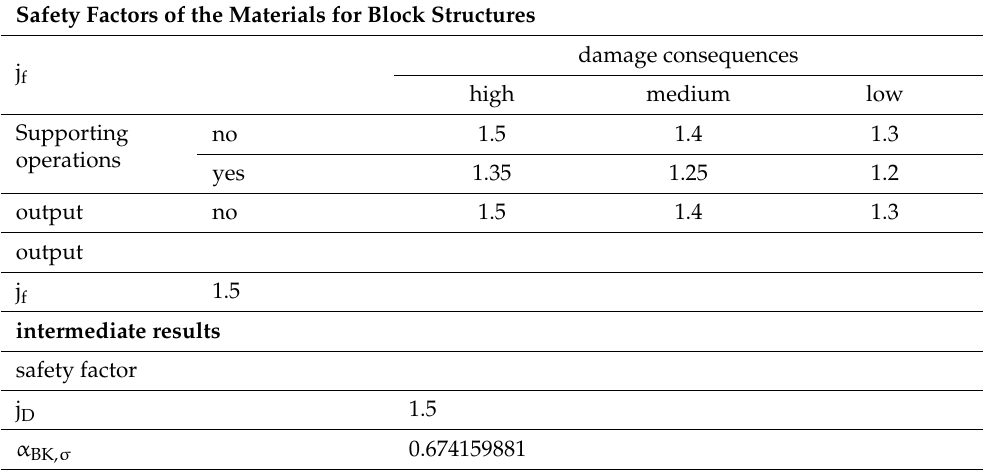
Table 15. The results of polymer-concrete operation under high amplitude